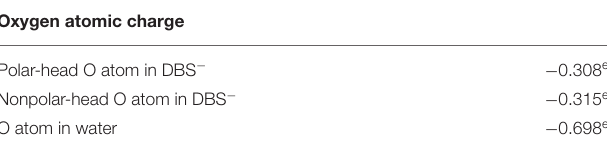
TABLE 2 | Oxygen atomic charge. Oxygen atomic